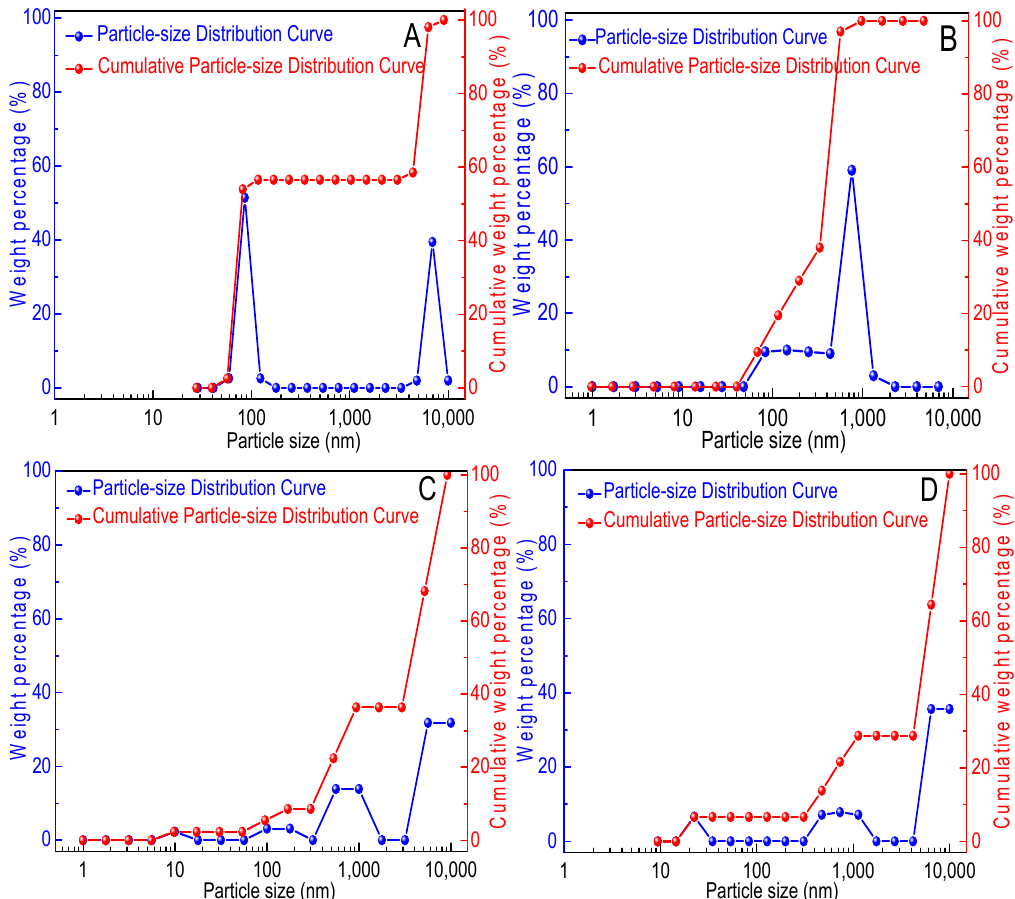
Figure 10. Particle size distribution of a 500 mg/L DiPHAM aqueous solution with different NaCl concentrations. ( A ) 4 × 10 4 mg/L; ( B ) 8 × 10 4 mg/L; ( C ) 12 × 10 4 mg/L; ( D ) 16 × 10 4 mg/L.